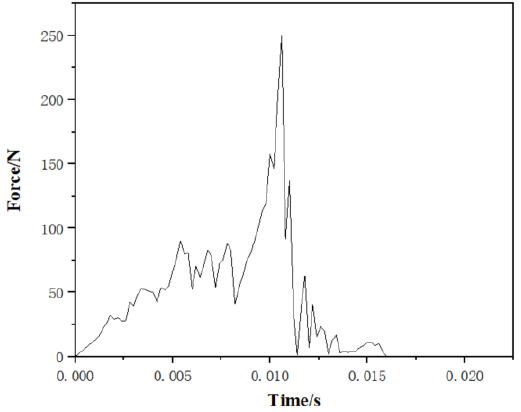
Figure 9. Shear force variation curve.